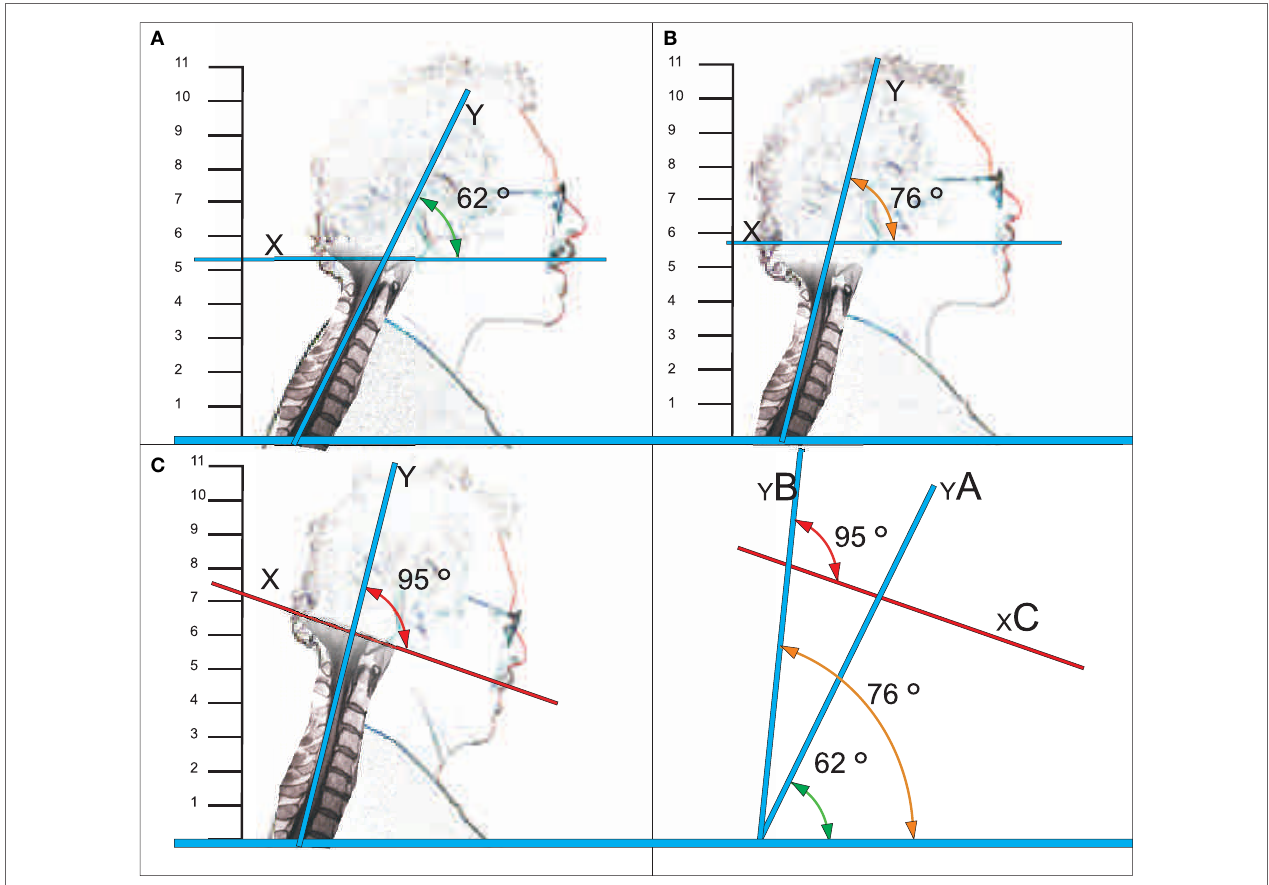
FIGURe 2 | Representation of tinnitus-related head postures and corresponding (posterior) craniocervical angles . Position A: tinnitus neutral position, Position B: tinnitus trigger point, and Position C: tinnitus maximum